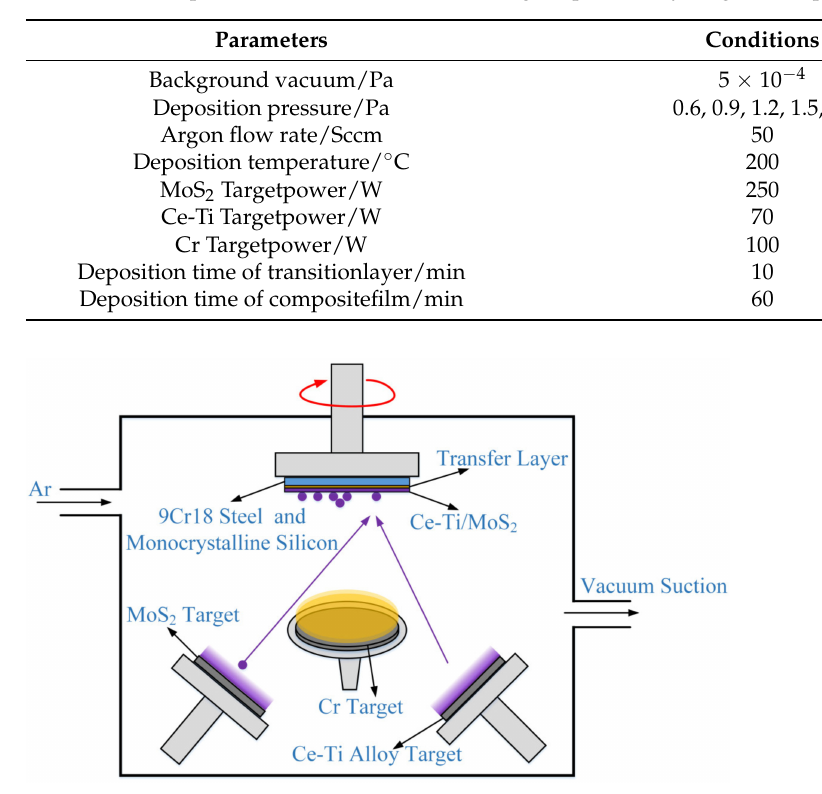
Table 1. Process parameters of Ce-Ti/MoS 2 coatings deposition by magnetron sputtering.